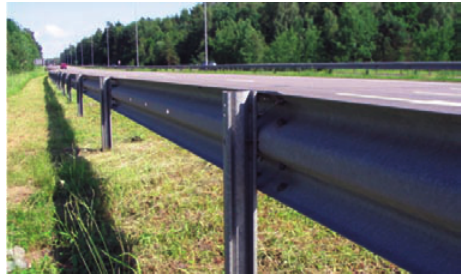
Fig. 1 . Metal safety barriers without inserts used in Lithuania, meeting the safety requirements of European Standard EN